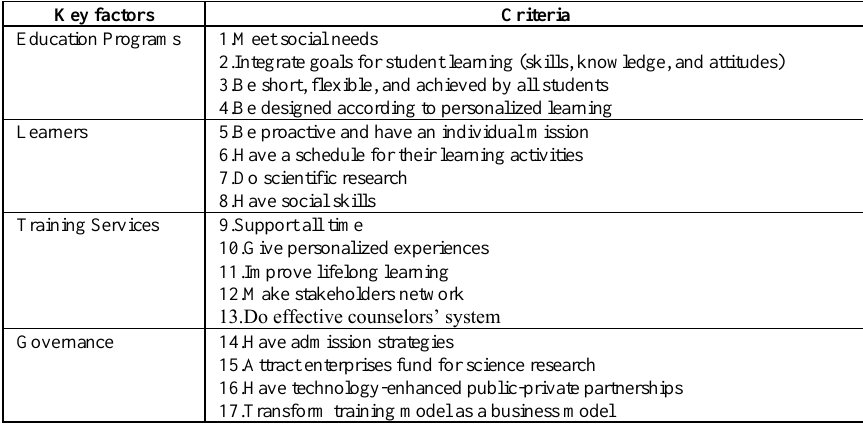
Table 1. Key factors and their